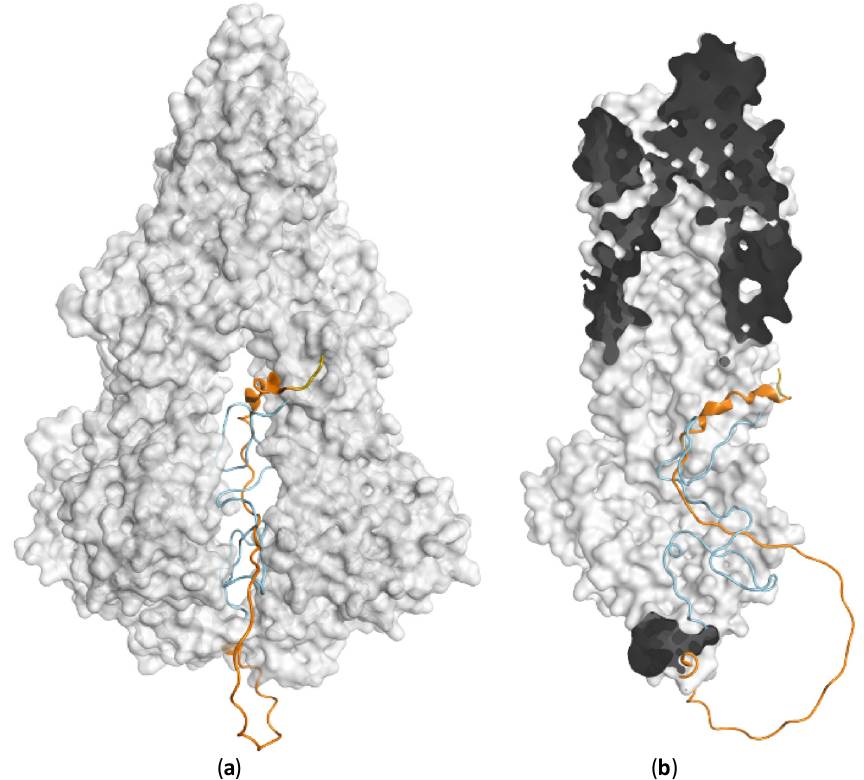
Figure 7. Flexible linker configuration between NBD1 and TMD2 of P-gp. Linker of AlphaFold-2 prediction colored in orange, indicating a low confidence pLDDT value. In comparison to the AlphaFold position, the model from dos Santos group packs the linker (in blue) tighter in the crevice. ( a ) Linker position in the interface of P-gp (linker from AlphaFold model in orange, linker from dos Santos group in blue). ( b ) The folding of the the linker viewed from the interface.